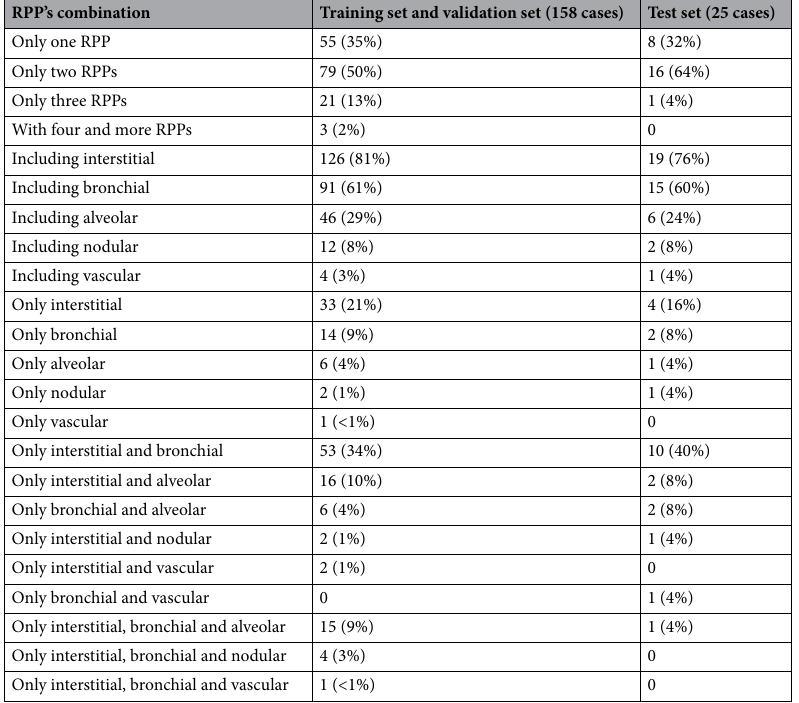
Table 2. Number (and relative percentage) of abnormal cases showing the following radiographic findings among abnormal cases used for the training and the